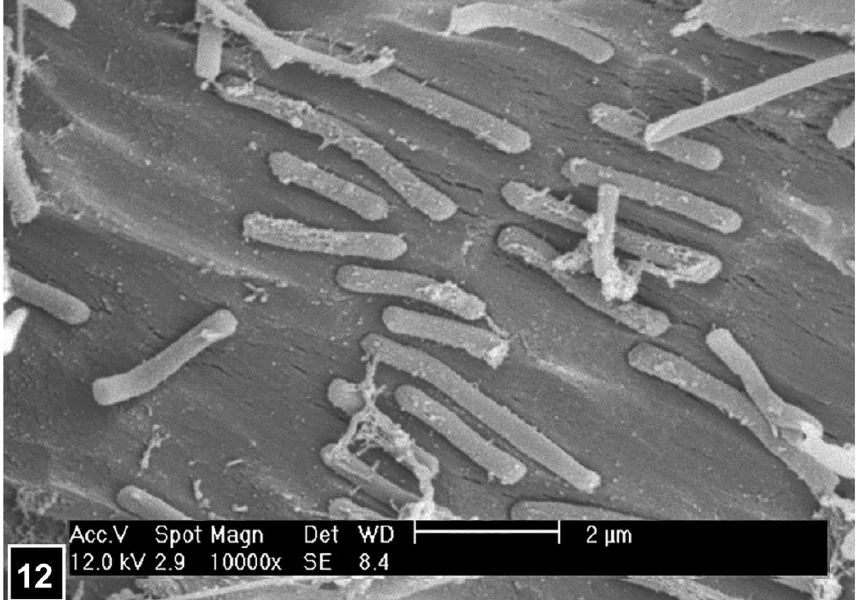
Figure 12. SEM of erosion bacteria and underlying erosion troughs produced during cell wall erosion. The micrograph courtesy of Professor Charlotte Björdal, University of Gothenburg, Sweden.